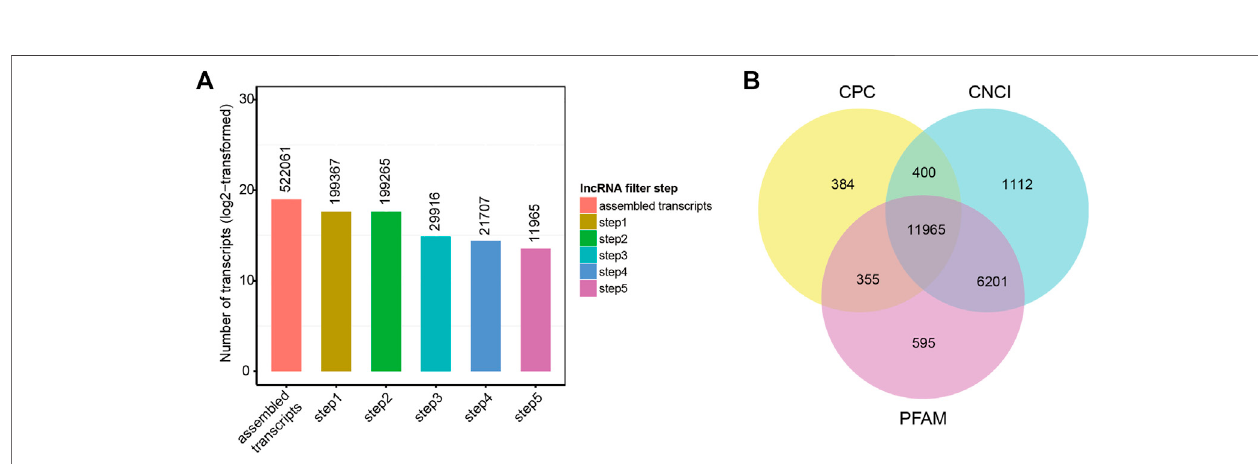
FIGURE 3 | Screening of the candidate lncRNAs in the ovine hypothalamus transcriptome. (A) 522,061 transcripts were assembled and 11,965 putative non- coding transcripts were retained for the next analysis after fi ve steps fi ltering. (B) lncRNAs identi fi cation was also used in CPC, PFAM, and CNCI.